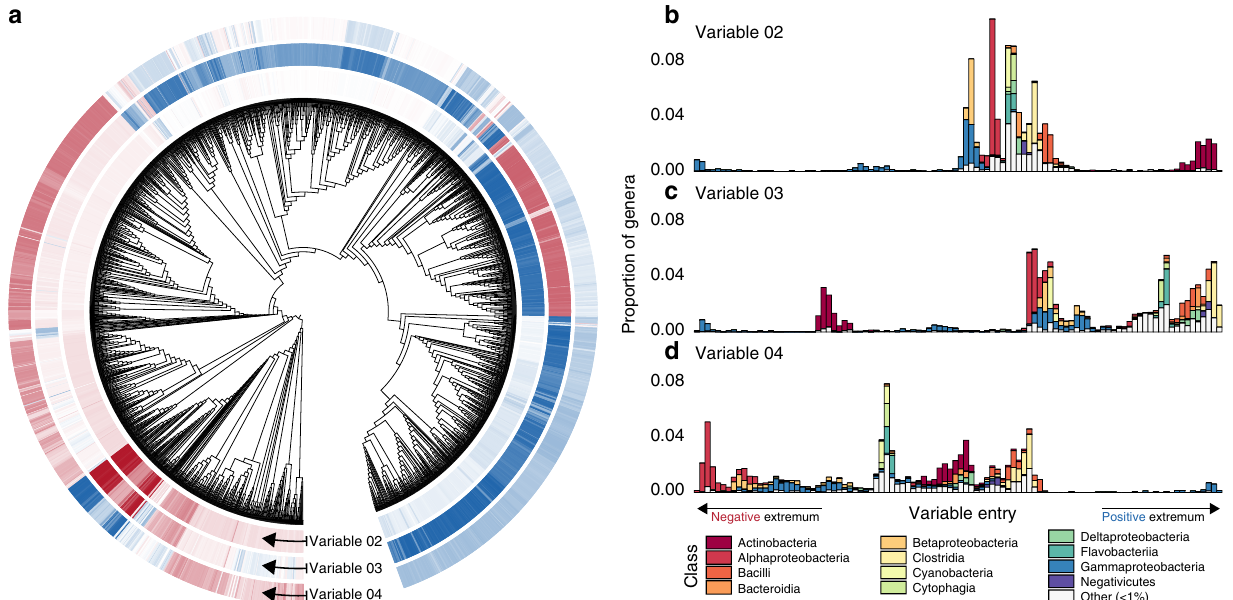
Fig. 2 A spectrum of class-level capabilities indicated by variables 2, 3, and 4. a Variable entries for each genome are shown as rings of tiles near the tips of a phylogenetic tree. Darker red and blue tiles mark genomes receiving larger (in magnitude) negative and positive variable entries; white tiles mark near- zero entries. b The ordering of taxa de fi ned by variable two entries, from negative to positive (left to right). The taxonomic compositions corresponding to variable entries are shown for each of 100 equally spaced bins. c The ordering of taxa de fi ned by variable three entries. d The ordering of taxa de fi ned by variable four entries. The variety of different values of these variables indicates a gradual shift in metabolic